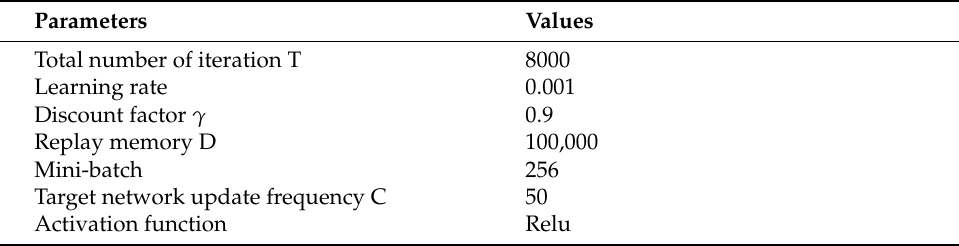
Table 3. Parameters of